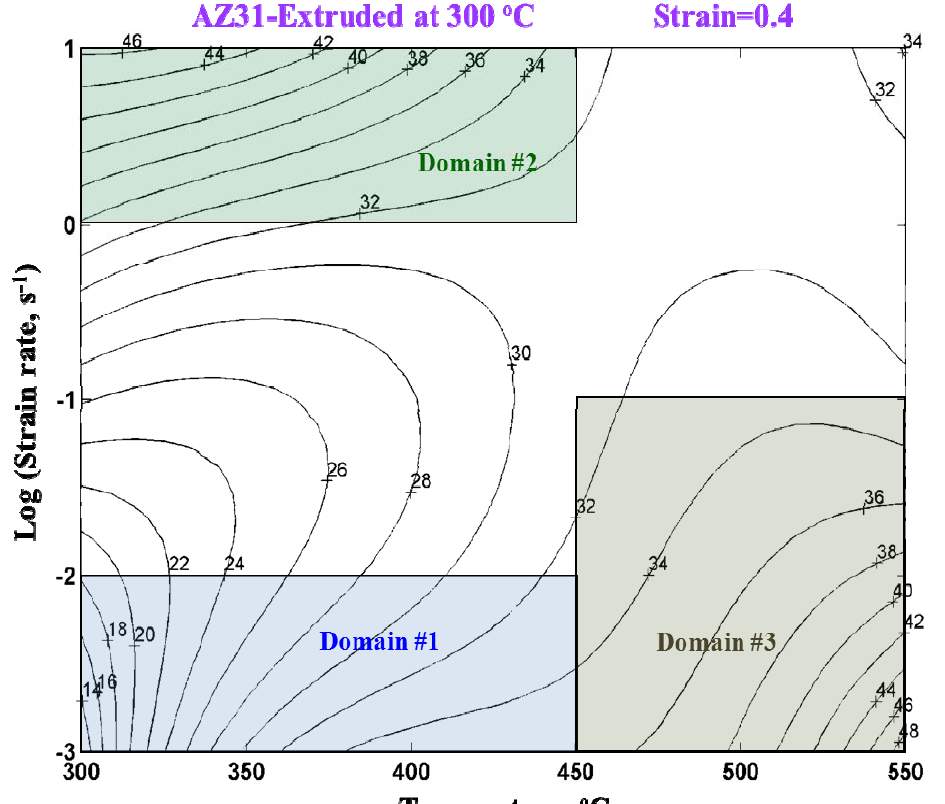
Figure 5. Processing map obtained at a strain of 0.4 for AZ31 magnesium alloy extruded at 300